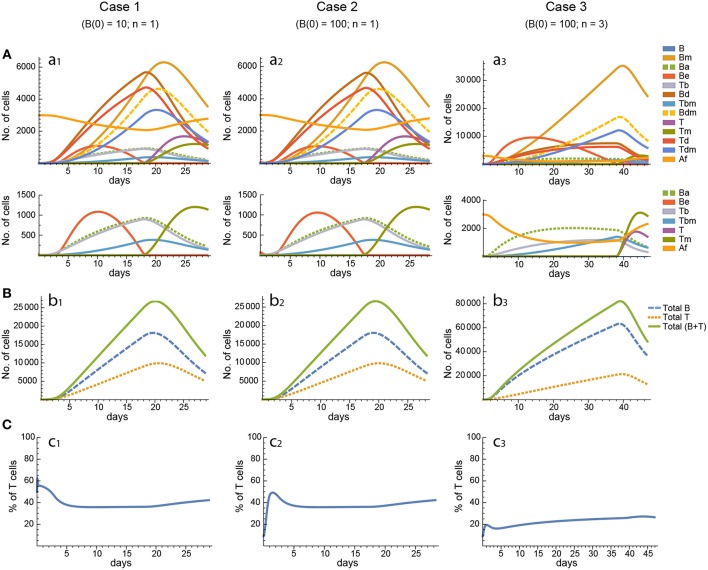
Reference dynamics of model 3. (A) Dynamics of individual compartments. The second row shows in detail the kinetics of those variables reaching low values. (B) Global dynamics. The dynamics of total B cells (BT), total T cells (TT), and total lymphocytes (BT + TT) are shown. (C) Percent of total T cells out of total lymphocytes. Parameter values used: μ2 = 0.10; c1 = 19.13 day−1(molec/GC)−1; c2 = 16.77 day−1(cell/GC)−1; p1 = 2.25 day−1; p1m = 1.16 day−1; db = 2.03 day−1; a1 = 19.43 day−1; a2 = 14.29 day−1; dbm = 1.20 day−1; p2 = 2.70 day−1; p2m = 1.63 day−1; dt = 0.39 day−1; Kb = 12632.48 cell/GC; Kt = 315.18 cell/GC.